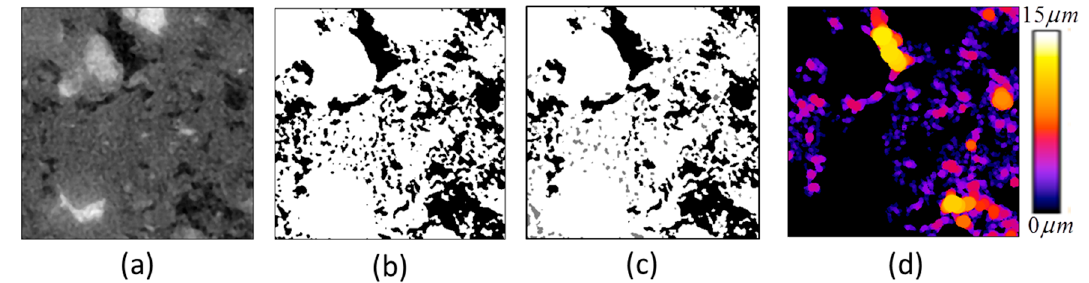
Figure 3. Image analysis for quantification of porosity and pore size: ( a ) An 8-bit representative grayscale slice (300 × 300 voxels) from VOI; ( b ) The binary image after segmentation (segmented porosity is imaged as black voxels); ( c ) The binary image after multiple cluster labeling (largest percolating pore cluster or effective porosity is imaged as black voxels whereas the smaller or isolated pore clusters are imaged as gray voxels); ( d ) Image resulting from local thickness algorithm to determine the mean pore size.